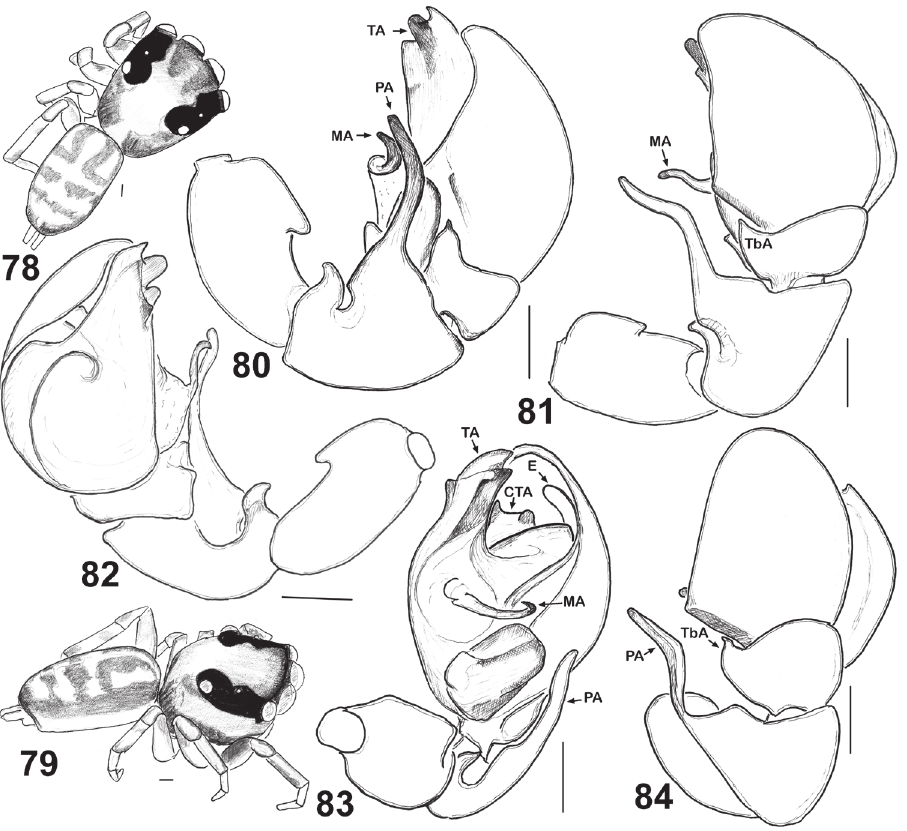
Figures 78–84. General appearance and copulatory organs of Eupoa prima ( ♂ paratype). 78 male body, dorsal view 79 ditto, lateral view 80 male palp, retrolateral view 81, 84 ditto, dorsal view 82 ditto, medi- an view 83 ditto, ventral view. Abbreviations as explained in ‘Material and methods’. Scale bars: 0.1 mm.